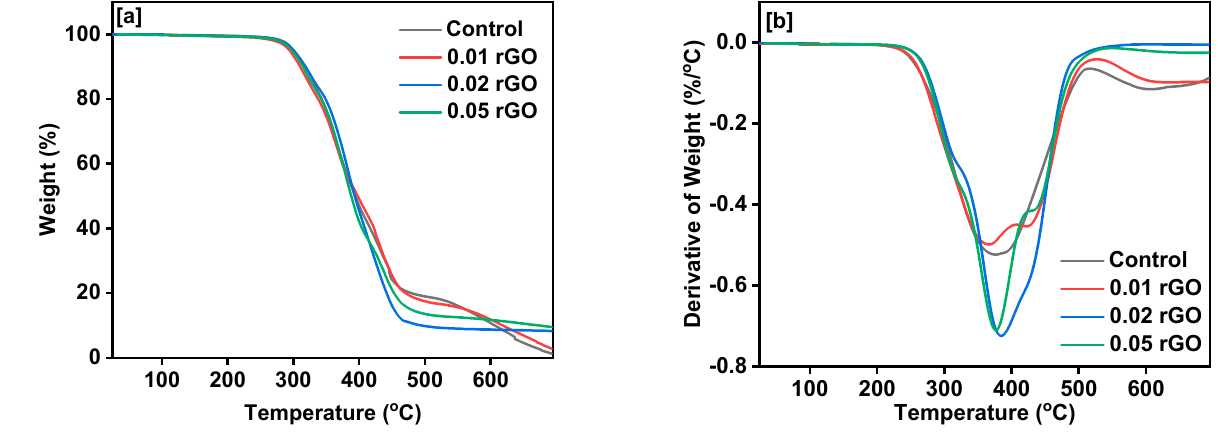
Figure 5. ( a ) TGA and ( b ) DTG curves of films.